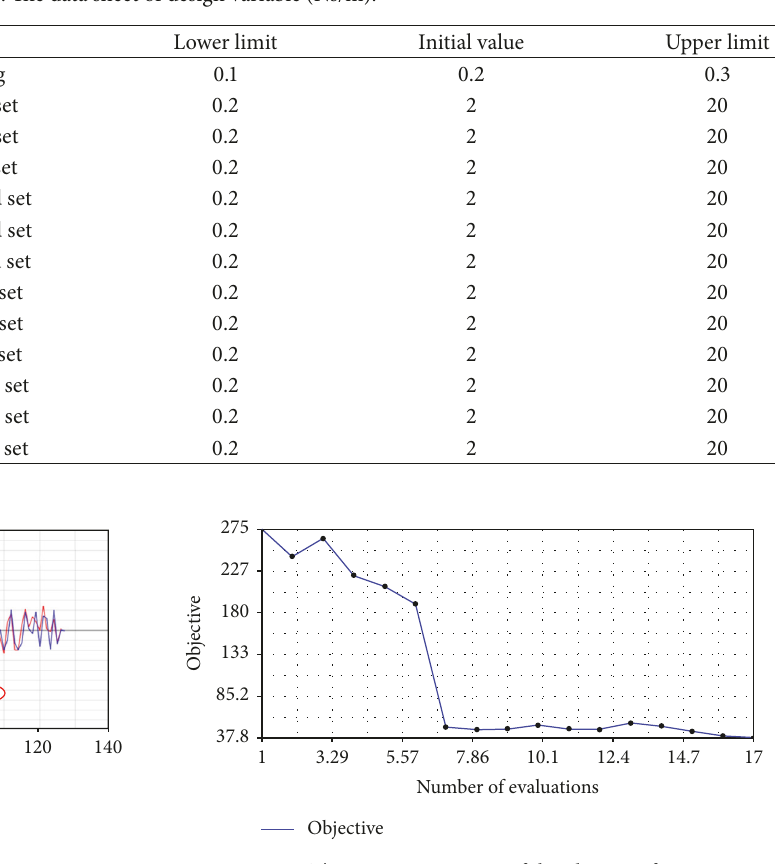
Figure 6: The output of the finite element calculation and experi- ment.